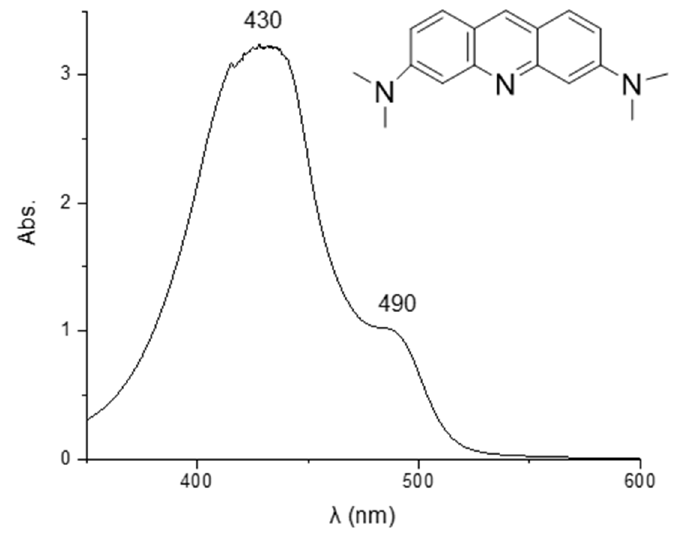
Figure 11. UV-Vis spectrum of acridine orange in ethanol (solution diluted 1:8).